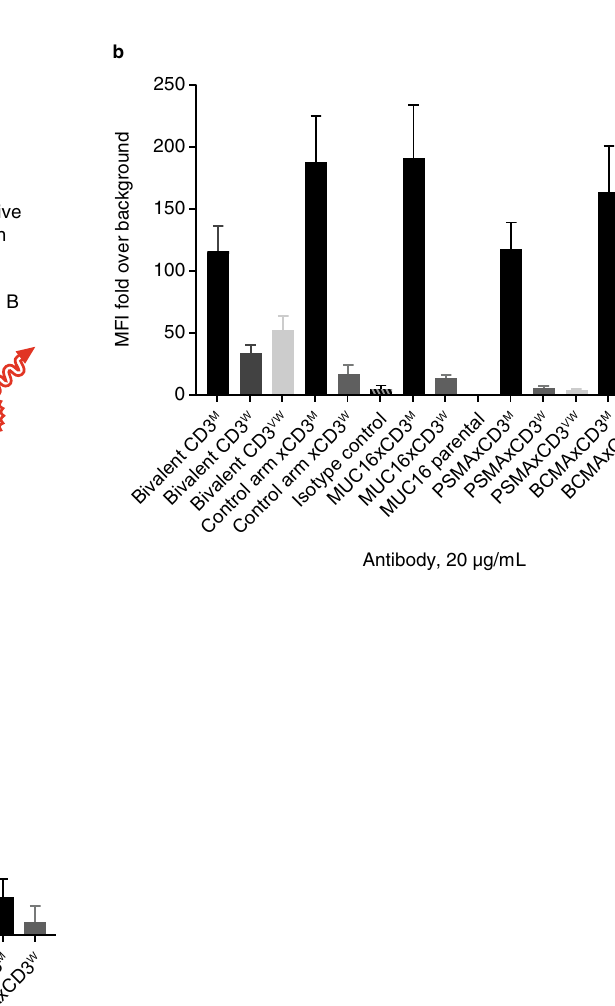
NFAT-luciferase (NFAT-luc) cell-based bioassay using Jurkat T cells as reporter cells and various tumor cell lines. Solid tumor-targeting bsAbs, MUC16xCD3 and PSMAxCD3, were tested with OVCAR-3 and C4-2 cells, respectively. Whereas RAJI-CD80/CD86-negative and NCI-H929 cells were utilized with bsAbs targeting hema- tologic cancers, such as CD20xCD3 and BCMAxCD3, respectively. In all the systems tested, the TSAxCD3 bsAbs displayed an activation of the reporter cells in the presence of tumor cell lines expressing the desired human antigen. The stronger CD3 arms consistently showed increased potency values over the weaker CD3 arms (differences between the CD3 W and CD3 VW arms were context- dependent), suggesting a dependency on the affinity of binding of the CD3 arm (Fig. 3a–d). No activation was